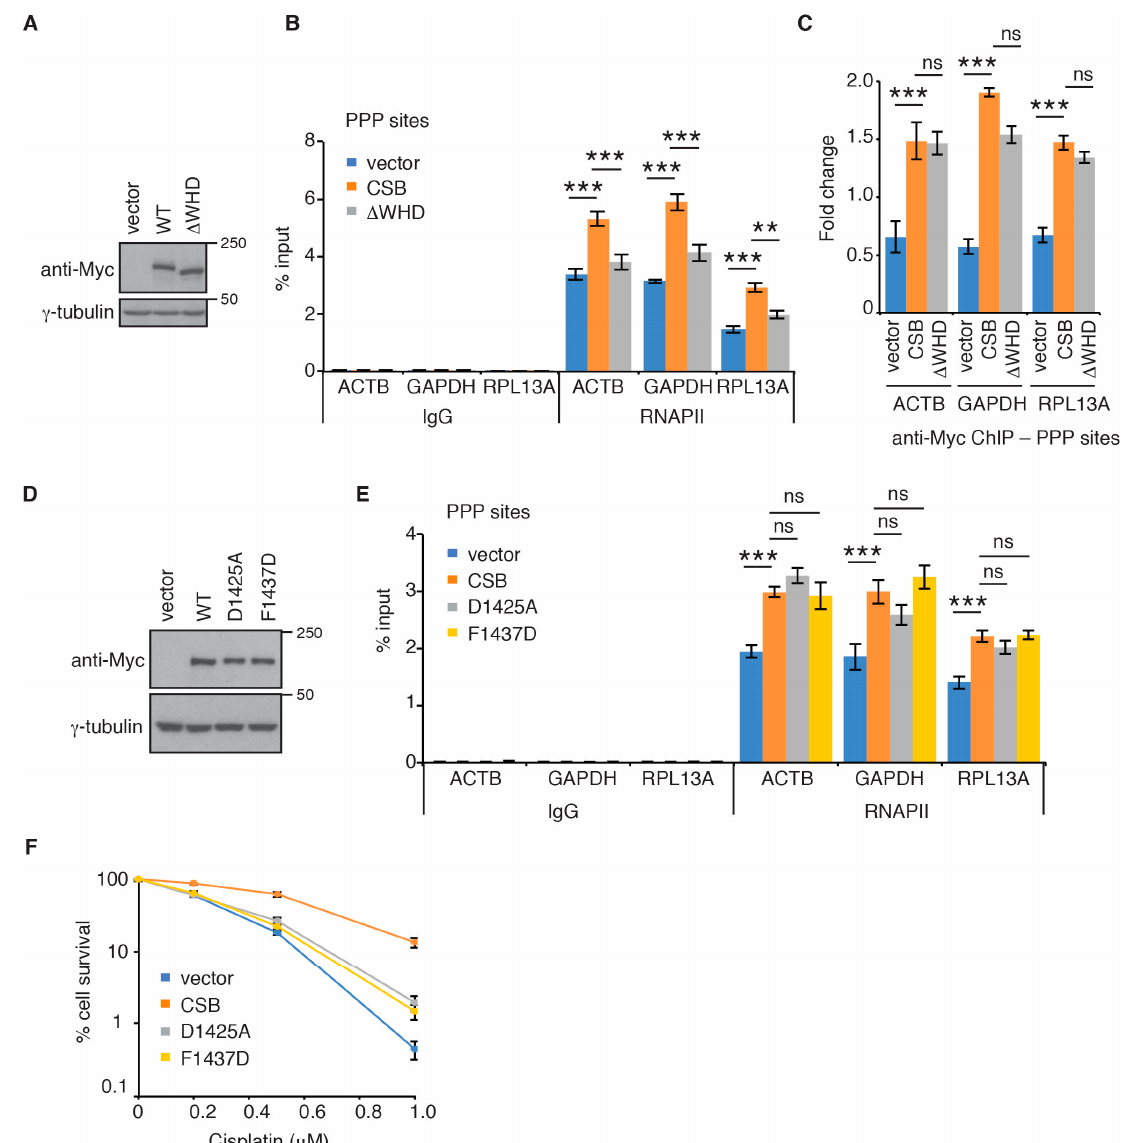
Figure 3. The CSB-WHD mediates RNAPII occupancy at PPP sites in a manner independent of its ability to bind to ubiquitin. ( A ) Western analysis of U2OS CSB-KO cells expressing the vector alone, Myc-CSB WT or Myc-CSB- ∆ WHD. Immunoblotting was performed with anti-Myc and anti- γ -tubulin antibodies. ( B ) RNAPII ChIP analyses of ACTB , GAPDH and RPL13A genes in U2OS CSB-KO cells complemented with the vector alone, Myc-CSB WT or Myc-CSB- ∆ WHD. Standard errors from three independent experiments are shown. p values were derived using the 2-way ANOVA test. *** p < 0.001; ** p < 0.01; ns: p > 0.05. ( C ) Anti-Myc ChIP analyses of of ACTB , GAPDH and RPL13A genes in U2OS CSB-KO cells complemented with the vector alone, Myc-CSB WT or Myc-CSB- ∆ WHD. Standard errors from three independent experiments are shown. p values were derived using the 2-way ANOVA test. *** p < 0.001; ns: p > 0.05. ( D ) Western analysis of U2OS CSB-KO cells expressing the vector alone, Myc-CSB WT, Myc-CSB-D1425A or Myc-CSB-F1437D. Immunoblotting was performed with anti-Myc and anti- γ -tubulin antibodies. ( E ) RNAPII ChIP analyses of ACTB , GAPDH and RPL13A genes in U2OS CSB-KO cells complemented with the vector alone, Myc-CSB WT, Myc-CSB-D1425A or Myc-CSB-F1437D. Standard errors from three independent experiments are shown. p values were derived using the 2-way ANOVA test. *** p < 0.001; ns: p > 0.05. ( F ) Cisplatin clonogenic survival assays of U2OS CSB-KO cells complemented with the vector alone, Myc-CSB WT, Myc-CSB-D1425A or Myc-CSB-F1437D. Standard deviations from three independent experiments are indicated.